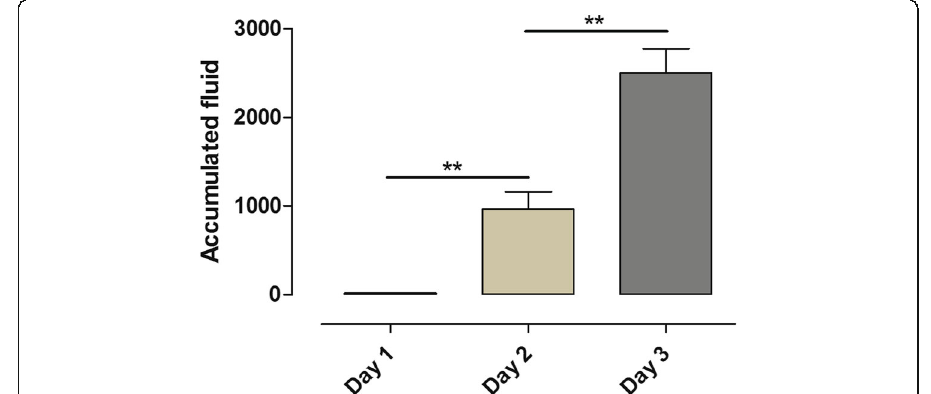
Fig. 5 The animals ’ total accumulated fluid balance during three consecutive days. Note how the total accumulated fluid balance significantly increased over the 3